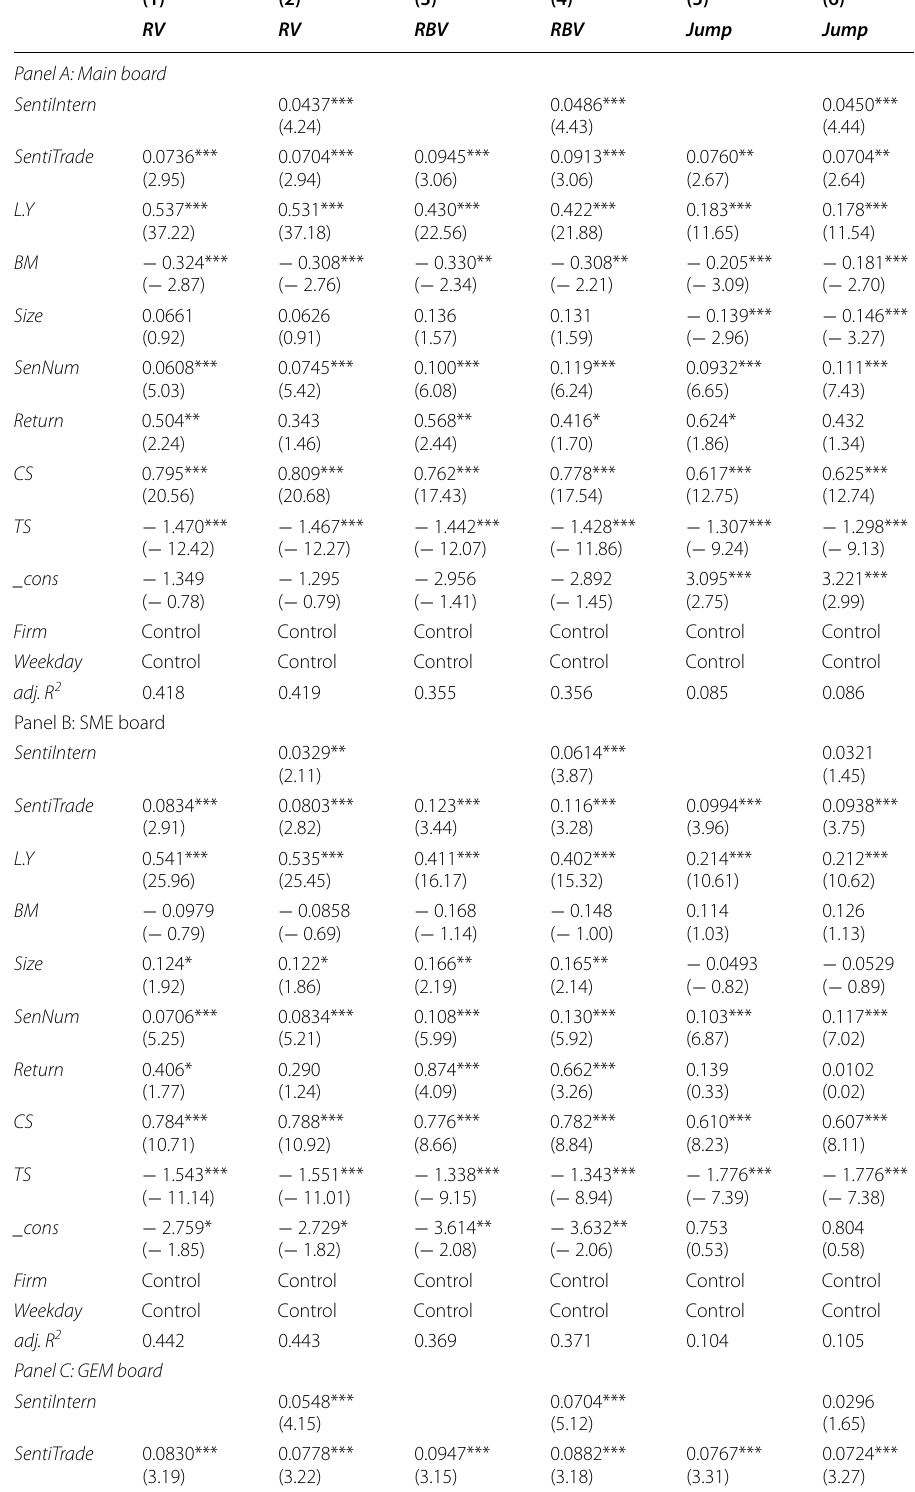
Table 6 The results of investor sentiments’ effects on volatilities in different